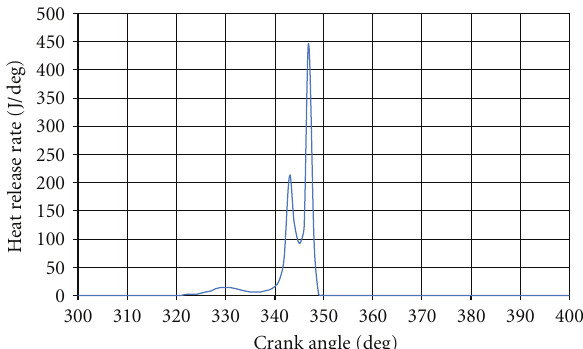
Figure 11: Heat release rate (1400rpm; 25% load; 17.5 CR, 0% EGR).